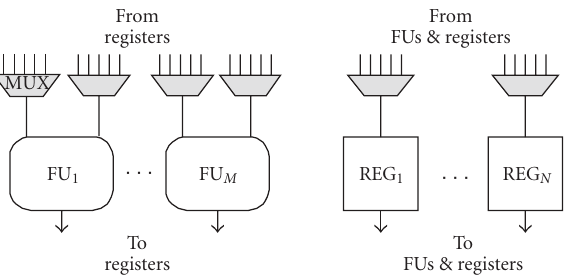
Figure 1: Datapath architecture: FUs, registers, and